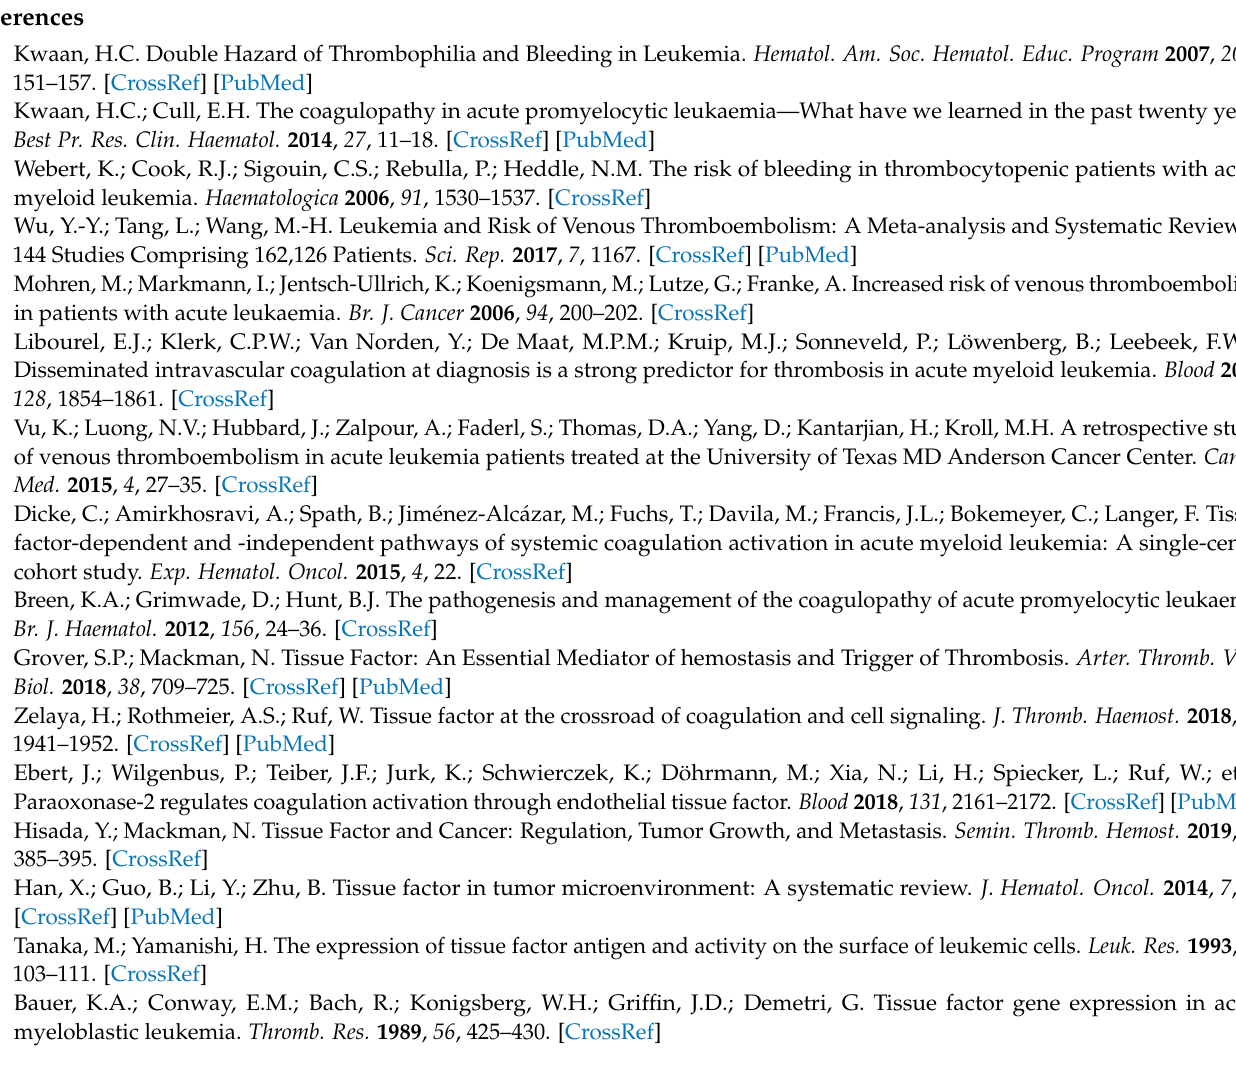
Figure S8: PDI inhibition on THP1 cells prevents activation of cryptic TF, Table S1: Demographic and clinico-pathological patient